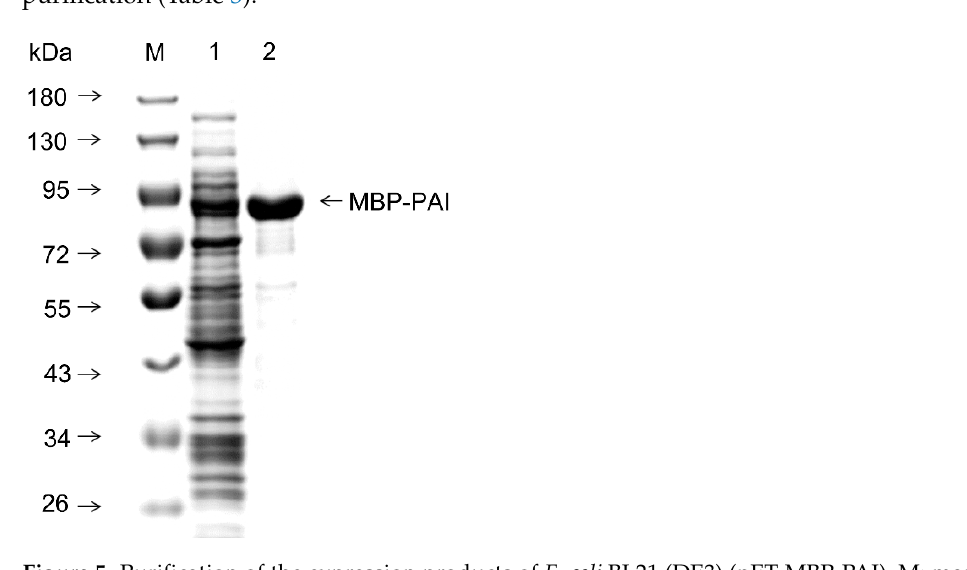
Figure 5. Purification of the expression products of E. coli BL21 (DE3) (pET-MBP-PAI). M: marker. Lane 1: crude enzymes after cell lysis; lane 2: purified MBP-PAI. Lane 1: crude enzymes after cell lysis; lane 2: purified MBP-PAI. Table 3. Purification of the MBP-PAI from E.coli BL21 (DE3) (pET-MBP-PAI). Table 3. Purification of the MBP-PAI from E. coli BL21 (DE3)